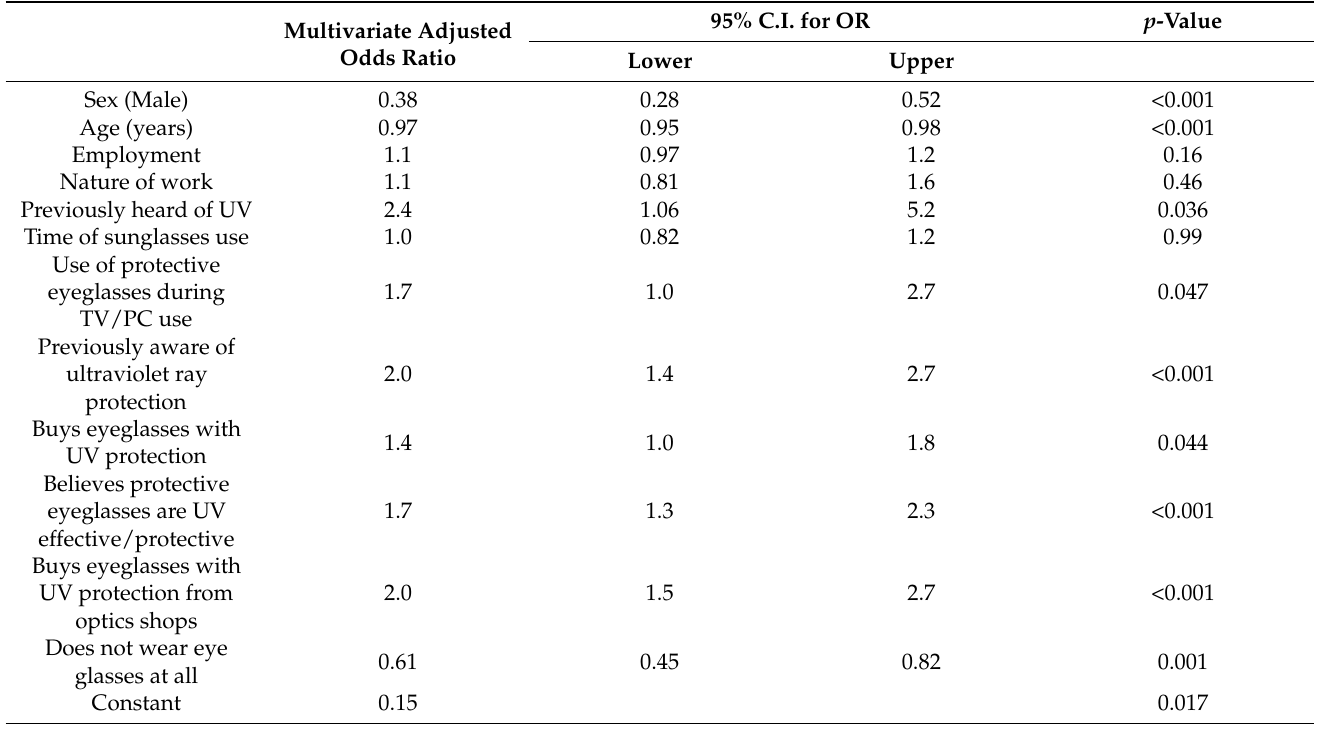
Table 4. Multivariate logistic regression analysis of participant knowledge of UV protection and